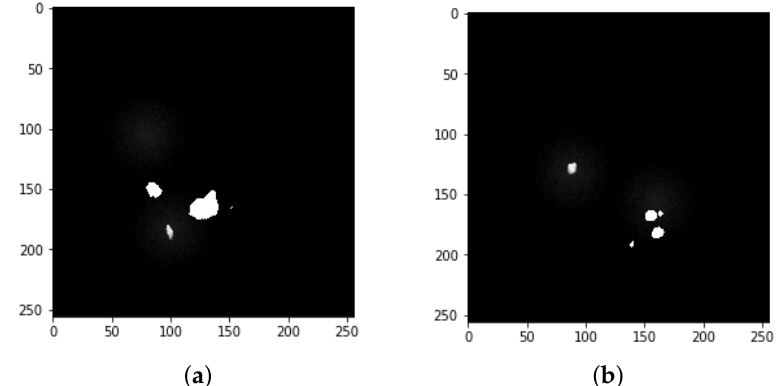
Figure 6. Image mask samples: both ( a , b ) show the detected tumors from the